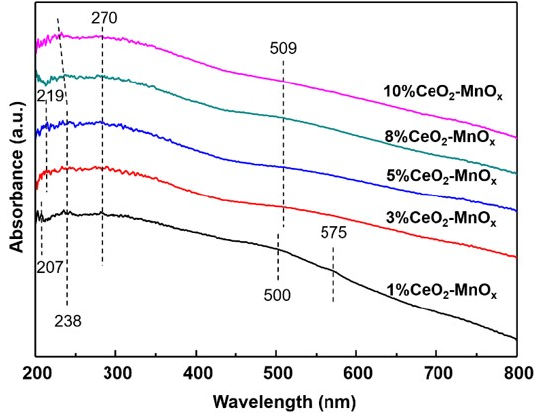
Figure 10. UV-Vis reflectance spectra of w CeO 2 –MnO X .